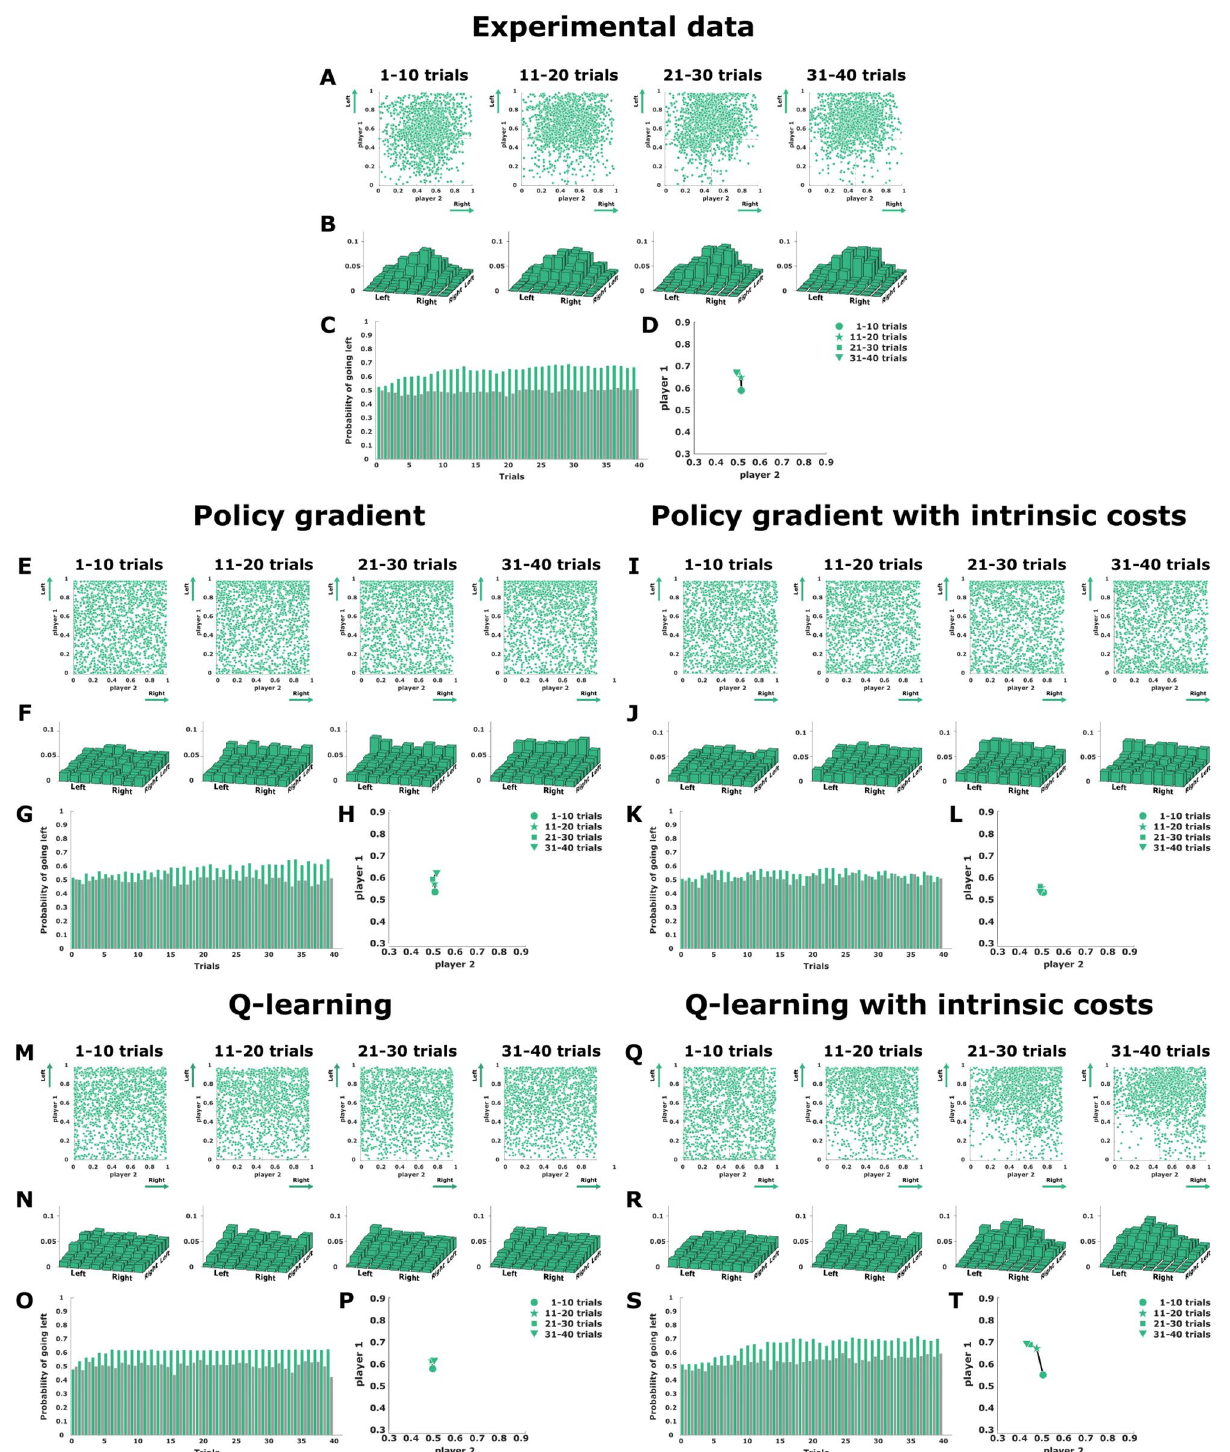
Figure 4. Asymmetric matching pennies. ( A ),( E ),( I ),( M ), and ( Q ) show final decisions as a scatter plot in the x 1 x 2 -plane, where subjects’ actions are expected to cluster in top quadrants. ( B ),( F ),( J ),( N ), and ( R ) show a two- dimensional histogram binning of the experimental scatter plots. ( C ),( G ),( K ),( O ), and ( S ) present the change of the mean endpoint (independently for each player) for each trial across the block of 40 trials. ( D ),( H ),( L ),( P ), and ( T ) show the direction of adaptation in the endpoint space. The experimental data is shown on the top, the four continuous models are below. Created using MATLAB R2021a (https:// www. mathw orks. com) 43